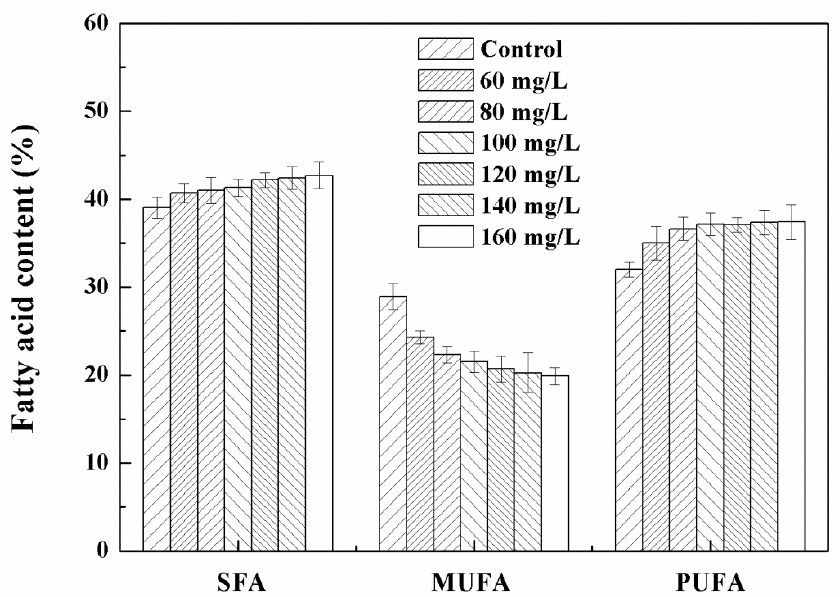
Figure 8. Fatty acid contents and components of Chlorella sp. UJ-3 exposed to different concentrations of Fe 3 O 4 NPs (Culture time: 21 days).